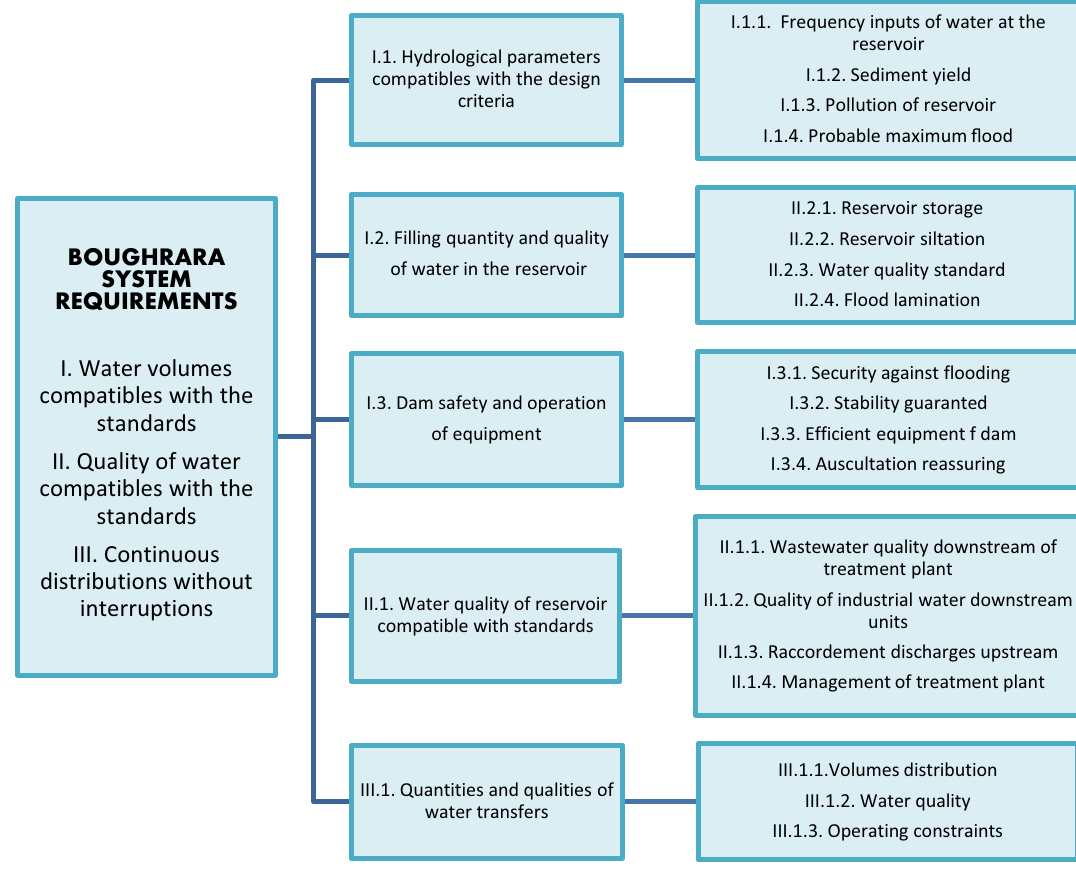
Fig. 6 Hierarchy of Boughrara system